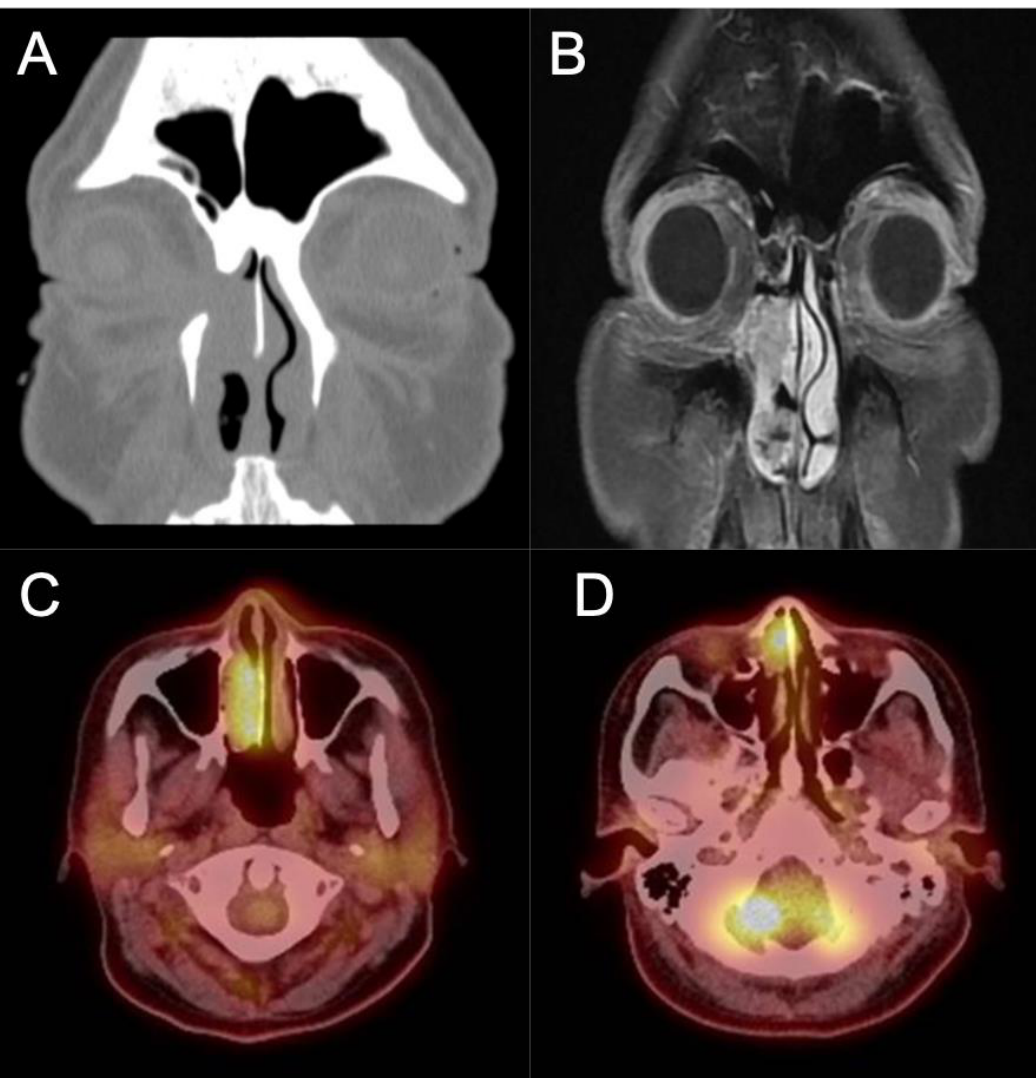
Figure 5. IP-degenerated squamous cell carcinoma. ( A ) Non-contrasted CT scan demonstrating an erosive mass in the right nasal cavity with invasion into the orbit. ( B ) T1 sequence contrasted MRI scan demonstrating the invasion of the mass into the medial orbit. ( C , D ) PET CT scan demonstrating avidity of the right nasal